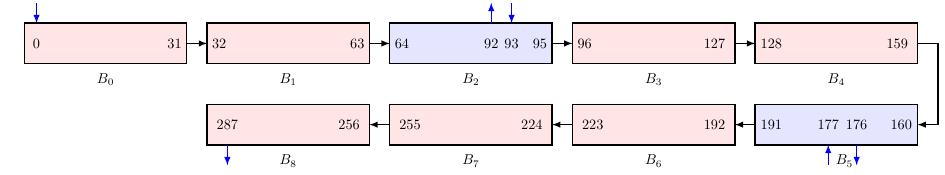
Figure 7: State registers of TRIVIUM (split into blocks of 32 bits)